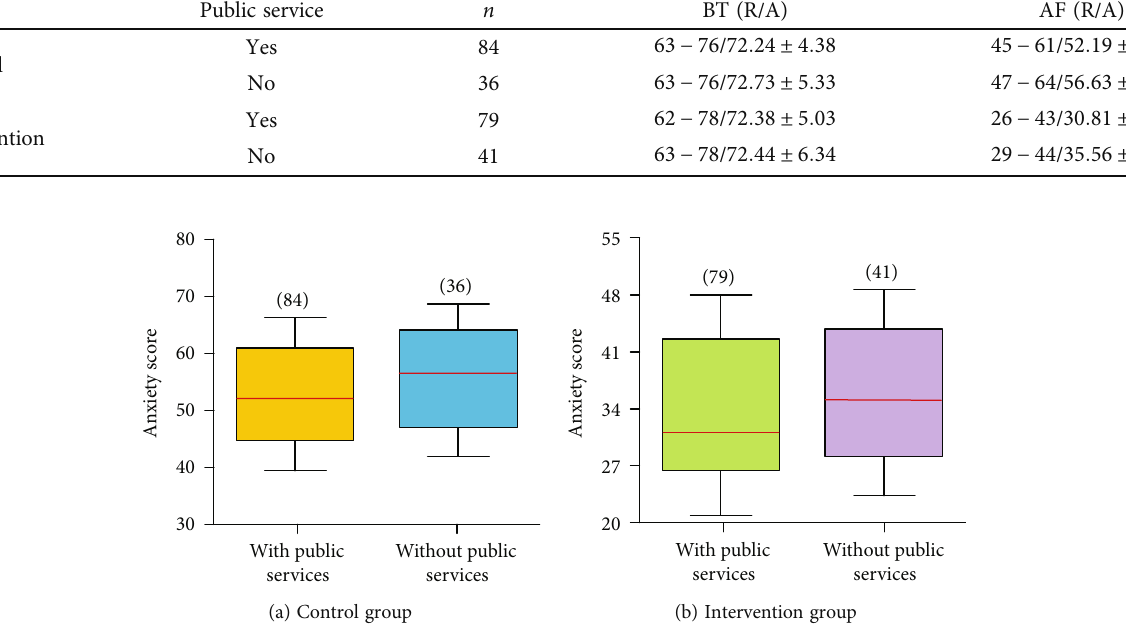
Figure 5: Anxiety evaluation results of college students with di ff erent public service experiences in the control and intervention groups after treatment. Table 8: Comparison of anxiety evaluation results of college students with di ff erent family background in the two groups before treatment (BT) and after treatment (AT) ( (cid:1) x ± s ). Note: R: range; A: average.